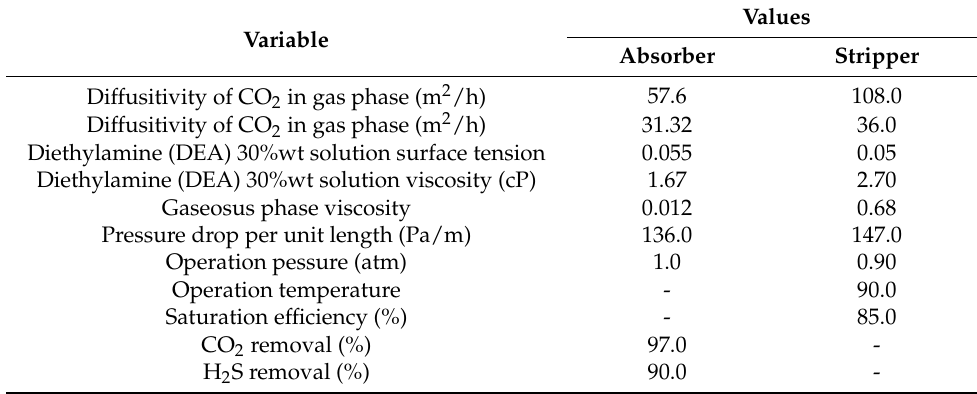
Table 2. Operating parameters of biogas upgrading process Modified from